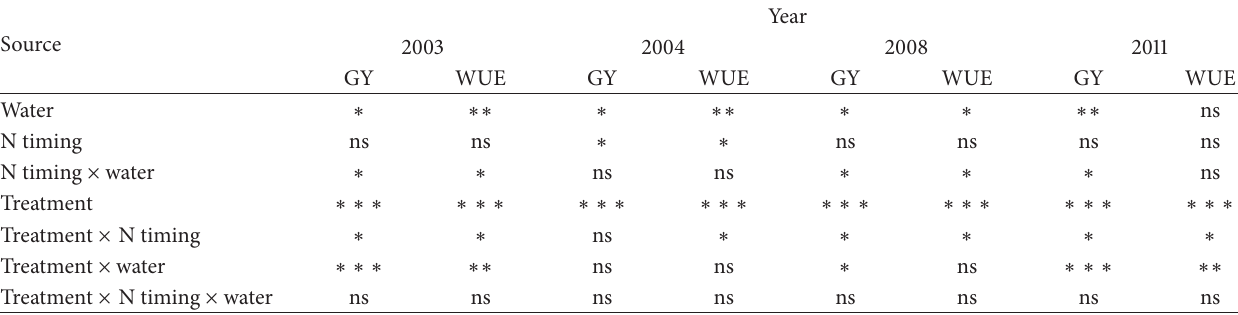
Table 3: Analysis of variance for main effects and interaction effects of factors affecting grain yield (GY) and water use efficiency (WUE) utilized in this study by growing